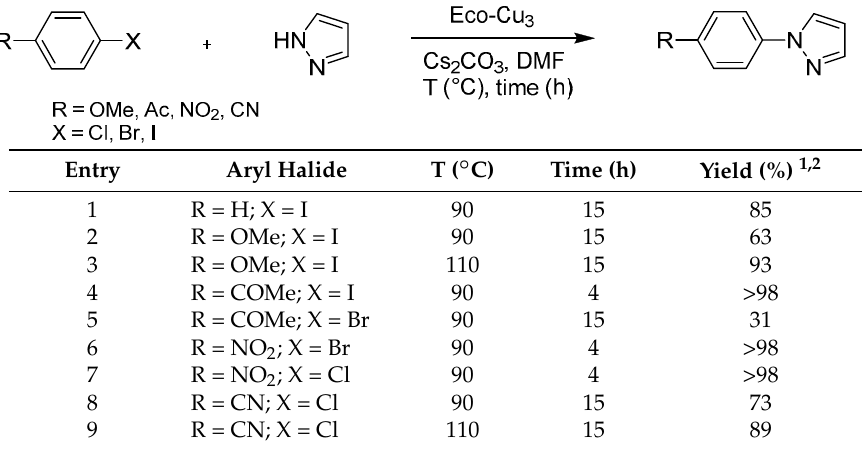
Table 8. The extension of the Ullmann reaction to other halogen derivatives.